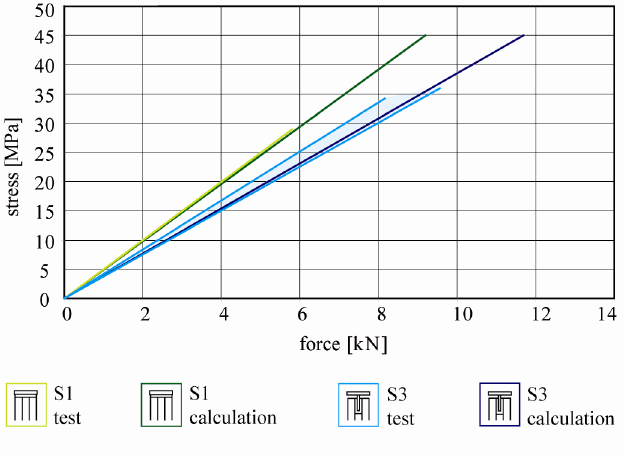
Figure 7. Comparison of the experimental force-stress diagram with the results of the numerical simula-